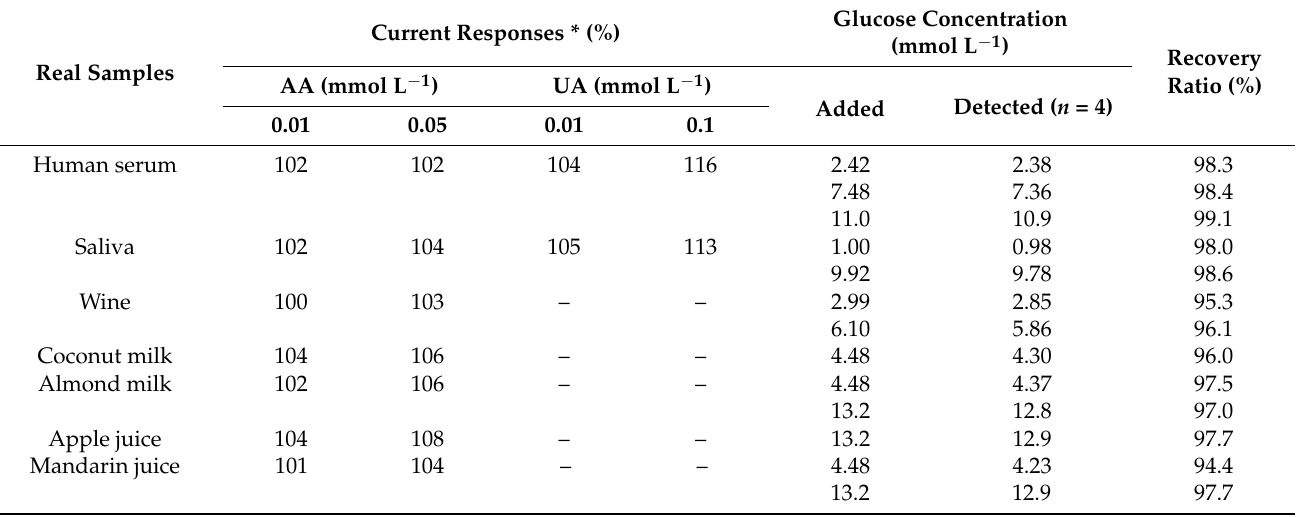
Table 2. The main results obtained in real samples using a biosensor based on the Ppy/GOx/DGNs/GR